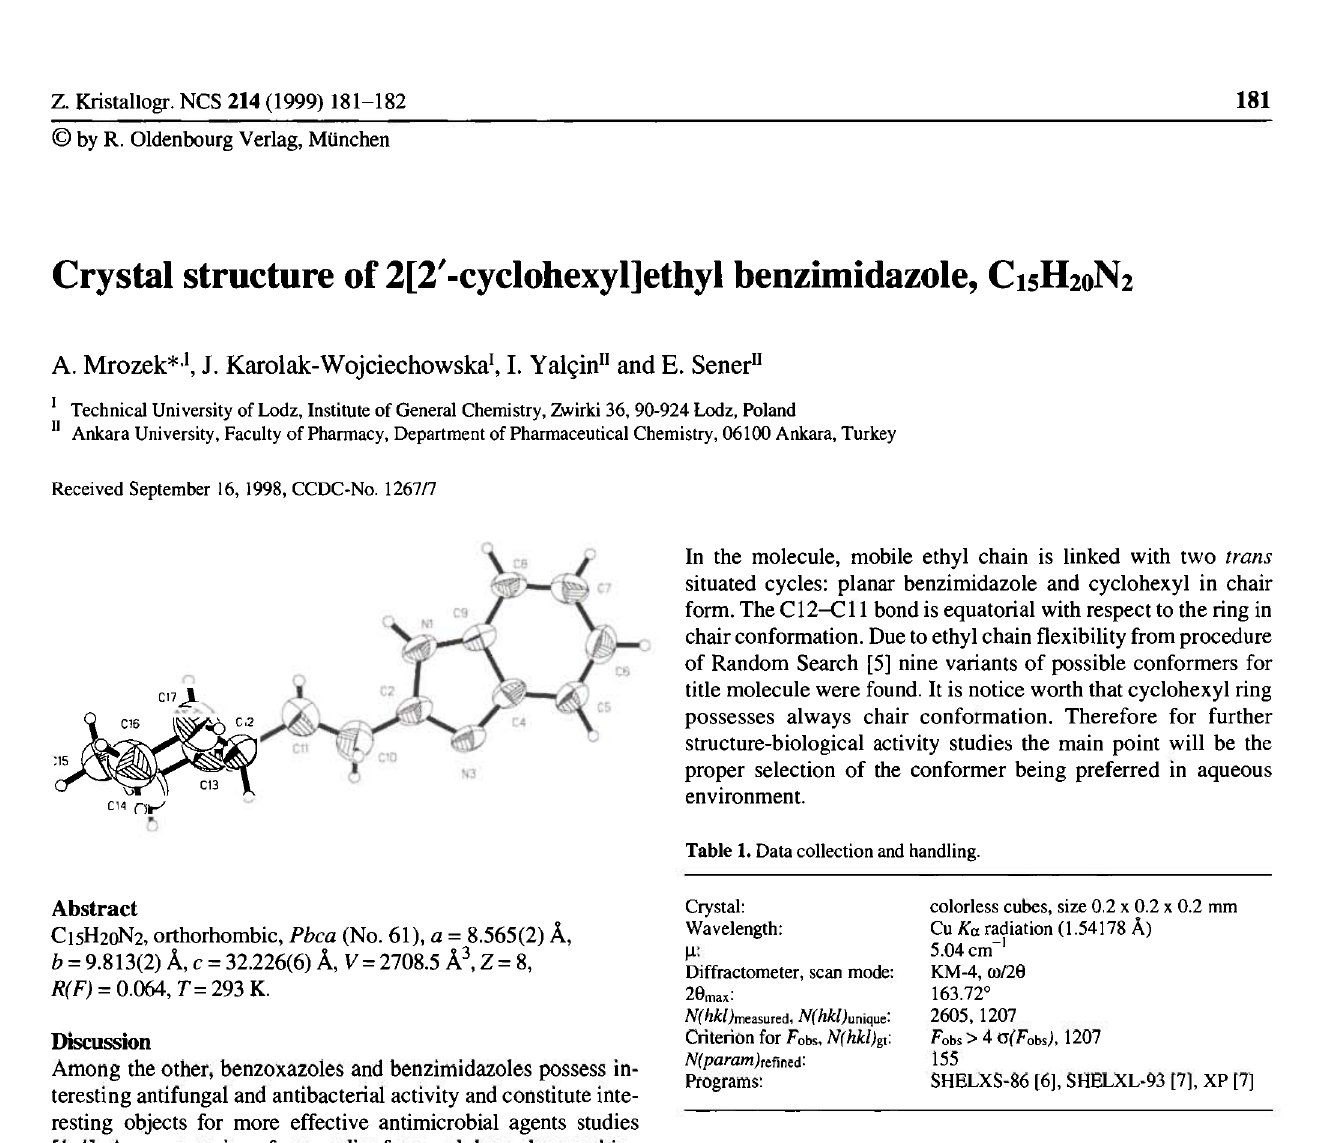
Table 2. Atomic coordinates and displacement parameters (Ä 2